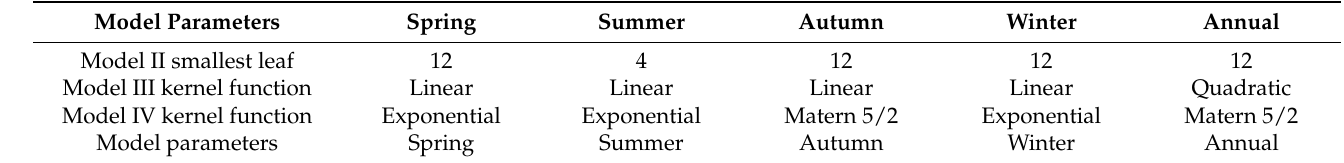
Table 1. Important parameters of the various PM 2.5 concentration estimation models based on machine